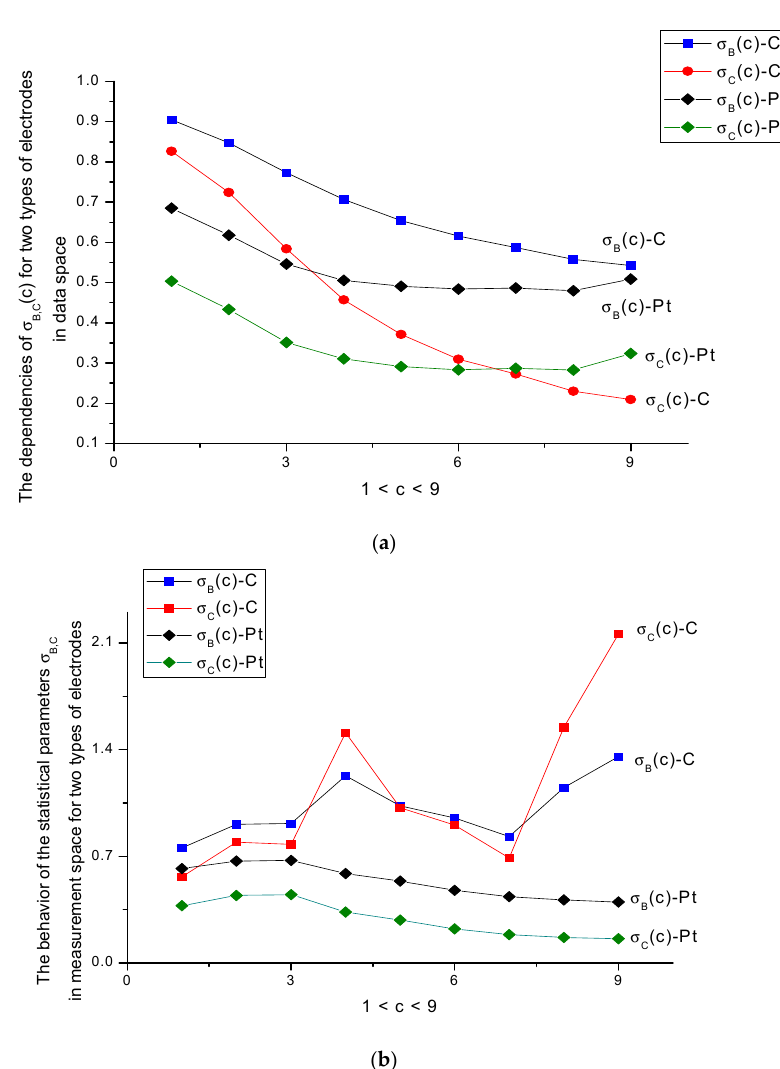
Figure 7. ( a ) Monotone behavior of the statistical parameters σ B (c) and σ C (c) in data space that can be chosen for calibration purposes. They independently confirm the behavior of the ellipse rotation (correlation) angle (see Figure 6) found for the discrete geometrical invariants (DGI) of the second order. ( b ) Random-like (non-monotone) behavior of the statistical parameters σ B (c) and σ C (c) in the measurement space for the C-electrode, which cannot be chosen for calibration purposes. They reflect the strong fluctuation characteristic of the measurement space, confirmed also by the parameters characterizing the invariant of the second order. As for the Pt-electrodes, these curves demonstrate quasi-monotone